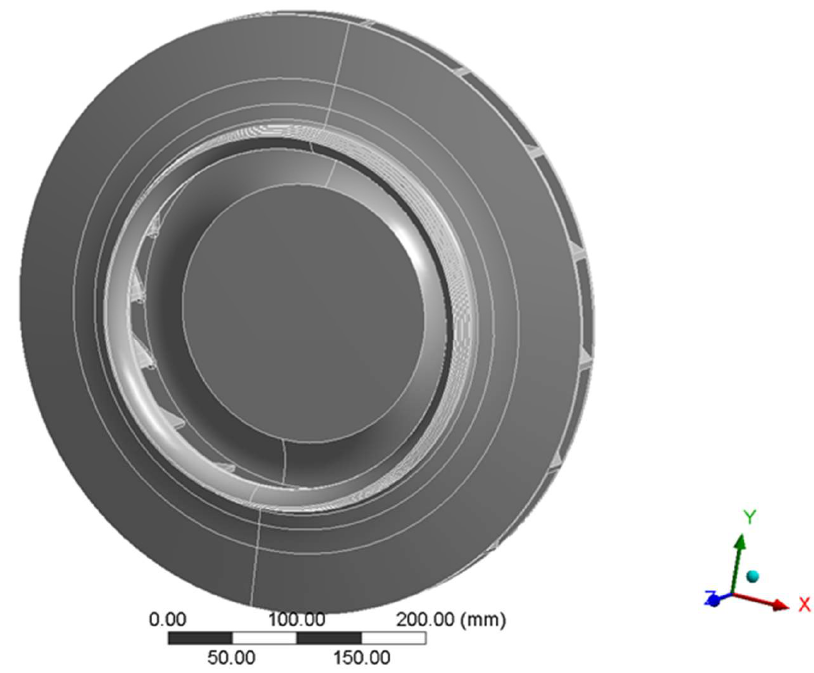
Figure 4. 3D model of the geometry of the impeller under analysis.